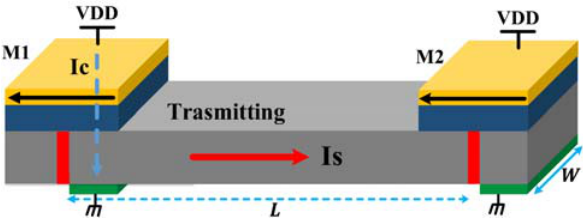
Figure 21. A simple all ‐ spin logic (ASL) with two magnets.